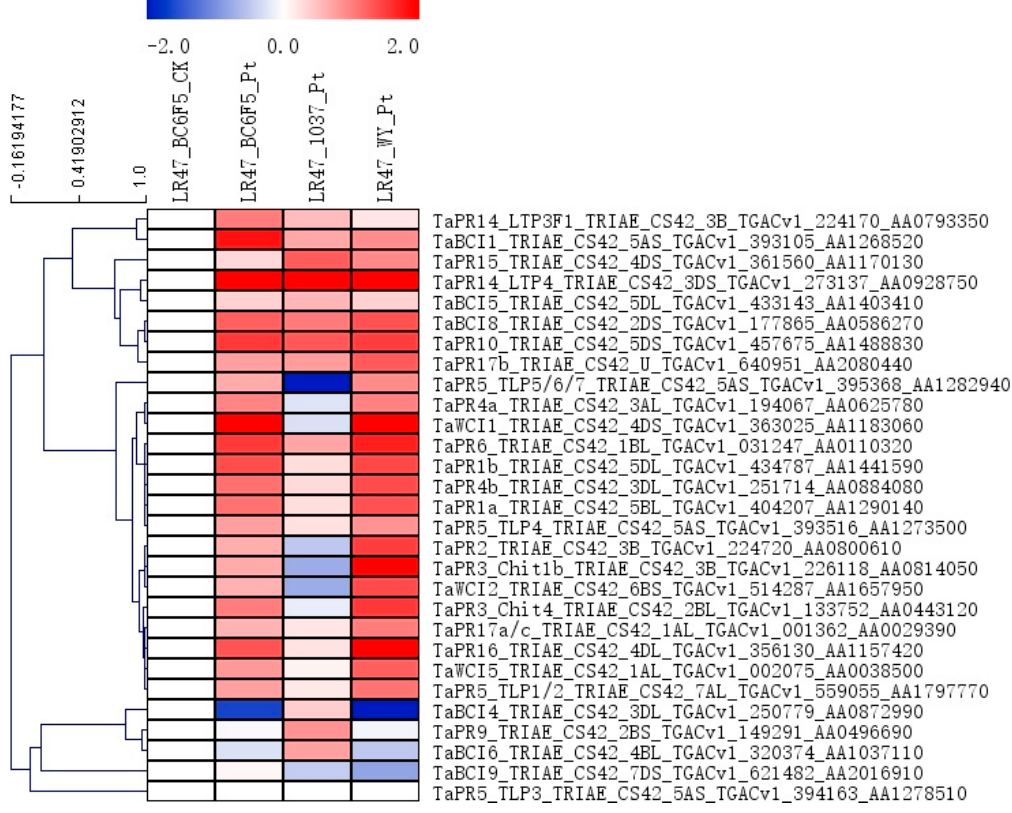
Figure 5. The expression profiles of pathogenesis-related ( PR) and BTH-sensitive genes during the Lr47 -mediated resistance. FPKM values for each of the genes in “LR47_BC6F5_Pt”, “LR47_1037_Pt”, and “LR47_WY_Pt” were relative to that in “LR47_BC6F5_CK”. A log2foldchange data transformation was conducted using Microsoft Excel software. A heatmap was generated by MeV software using the relative expression data of PR and BTH-sensitive ( WCI and wheat homologs of BCI ) genes. Genes with similar expression patterns were clustered using the “hierarchical clustering” function of the MeV software. LR47_BC6F5_CK: water-inoculated “Lr47-Yecora Rojo-BC 6 F 5 ”,